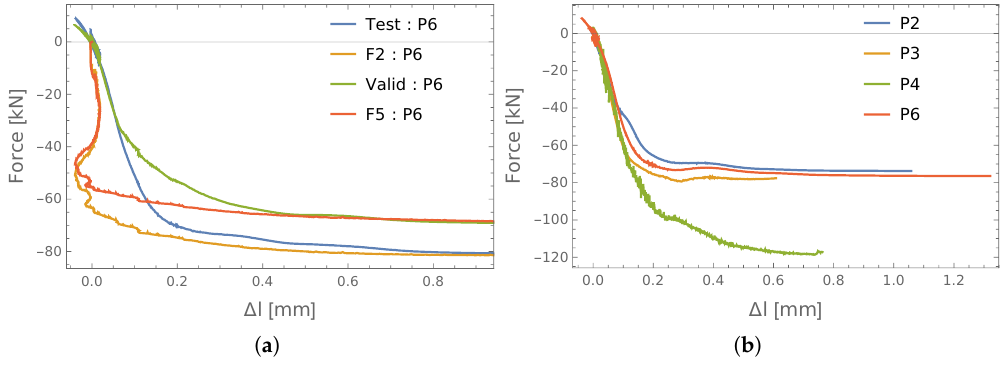
Figure 11. The results of force identification: ( a ) testing; ( b ) prediction.